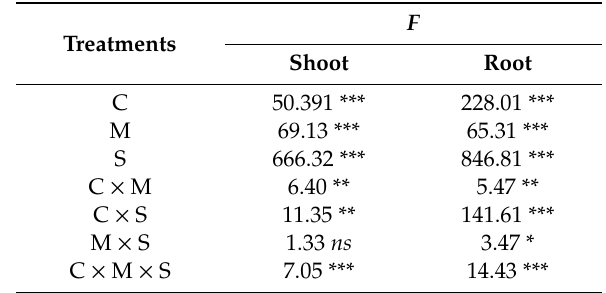
The values in the table represent analysis of variance (ANOVA) test for biomass of the wheat cultivars (C) under microbial treatment (M), salt stress (S), and their interaction (C × M, C × S, M × S and C × M × S). *, **, ***, and ns denotes that the mean di ff erence is significant at the p < 0.05, p < 0.01, p < 0.001 and nonsignificant levels,